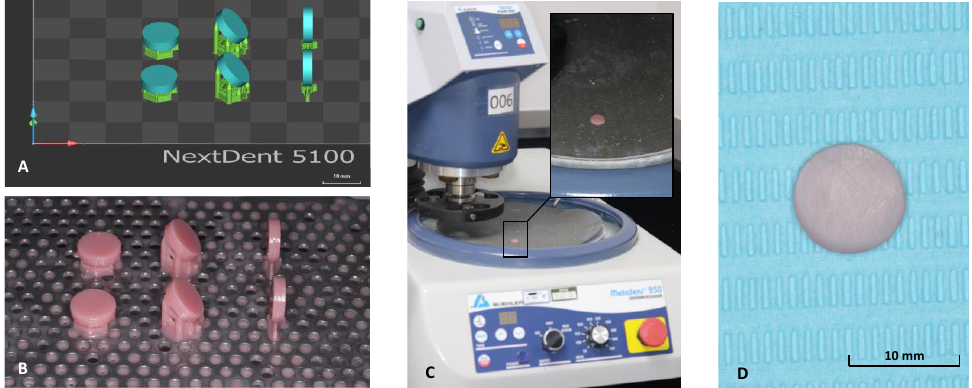
Figure 2. ( A – D ) Summarization of fabrication process 3D-printed samples. ( A ) Virtual design of the sample with printing orientation (0, 45, 90-degree), ( B ) printed samples before post-curing process, ( C ) polishing machine (AutoMet250, Buehler Ltd., Lake Bluff, IL, USA) with unpolished disc, and ( D ) polished disc. To evaluate the specimens’ surface roughness (surface roughness average, Ra), a pro- filometer (non-contact; Contour Gt-K1 optical profiler; Bruker Nano, Inc., Tucson, AZ, USA) was used, in which each specimen was mounted on the automated x-y stage. Five different points were scanned using scanning parameters as described by a previous study [32]. Following that, the capture images were used to calculate the averaged surface roughness (um) per specimen, Figures 3 and 4 [3]. For the hardness value, a Vickers tester (Wilson Hardness; ITW Test and Measurement GmbH, Shanghai, China) was used with a pyramid-shaped diamond indenter used to indent each specimen with a 50 g load and 30 sec dwell-time at three different areas per specimen followed by average calculations. [5].